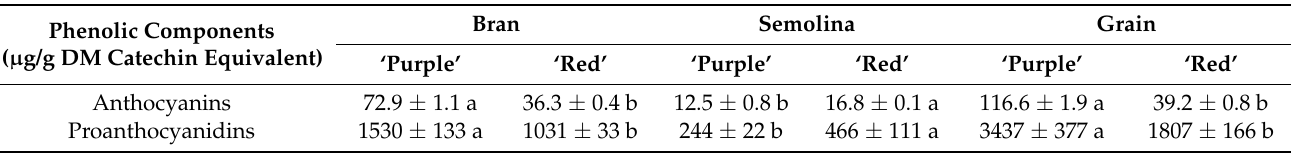
Table 4. Anthocyanins and proanthocyanidins in the ‘Purple’ and ‘Red’ landraces. Values are reported as mean ± SD ( n = 5). Significant differences between the two varieties for bran, semolina, or grain are indicated by lowercase letters ( t -test, p <